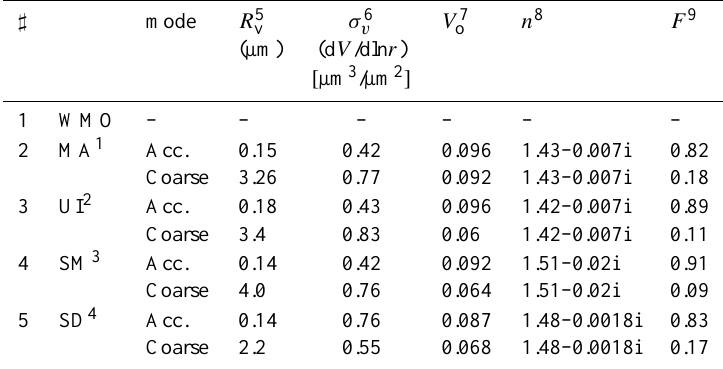
Table 1. Physical and optical parameters of the aerosol models used in the algorithm (Omar et al., 2005). ] mode R 5 v σ 6 v V 7 o n 8 F 9 (µm) (d V /dln r ) [ µm 3 /µm 2 ] 1 WMO – – – – – – 2 MA 1